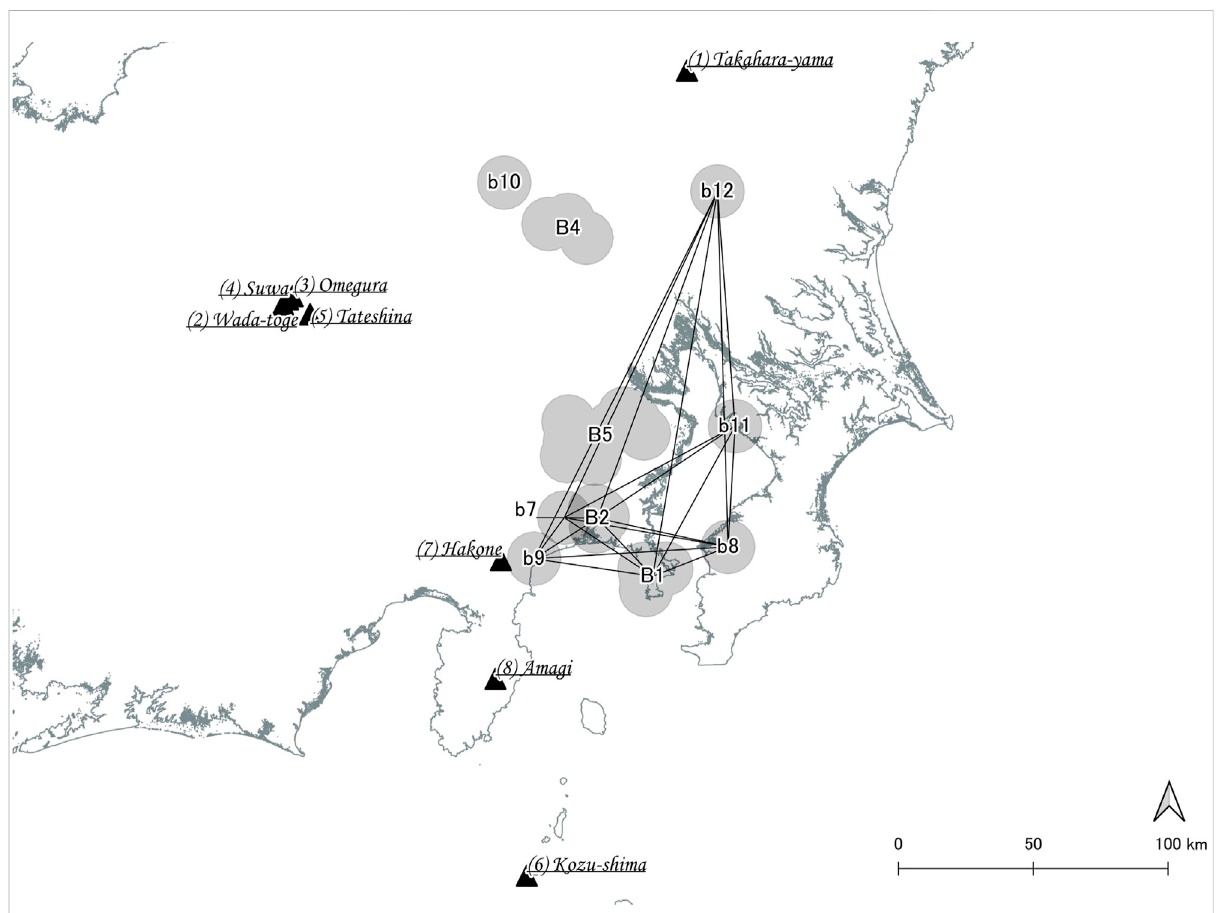
FIGURE 8 Network among consumption areas in Period 1, the beginning Jomon period and the earlier Jomon period (16,000 – 7,000 years cal BP). Clusters are represented by uppercase characters and single sites by lowercase characters. Pairs with a cosine similarity of more than 0.9 in the composition ratio of each provenance area are